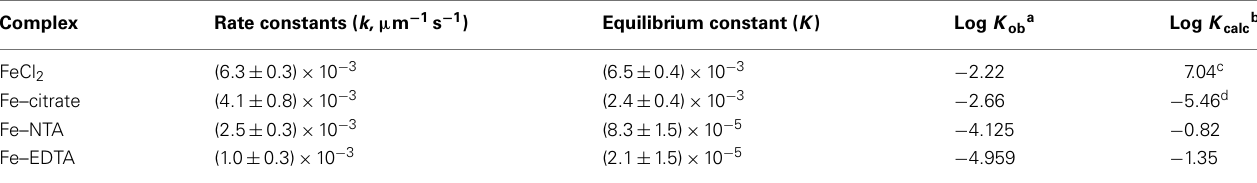
Table 1 | Kinetic parameters for Fe-complexes oxidation by MtoA at pH